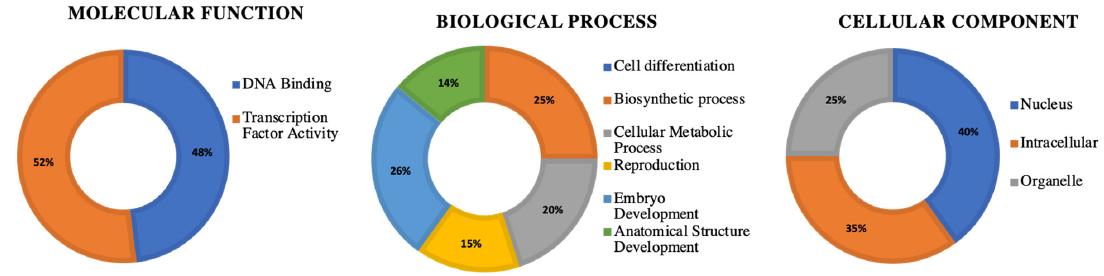
Figure 9. Gene Ontology analysis of TCP genes in L. chinense, categorized into three processes: molecular function, biological processes, and cellular components from left to right, respectively.